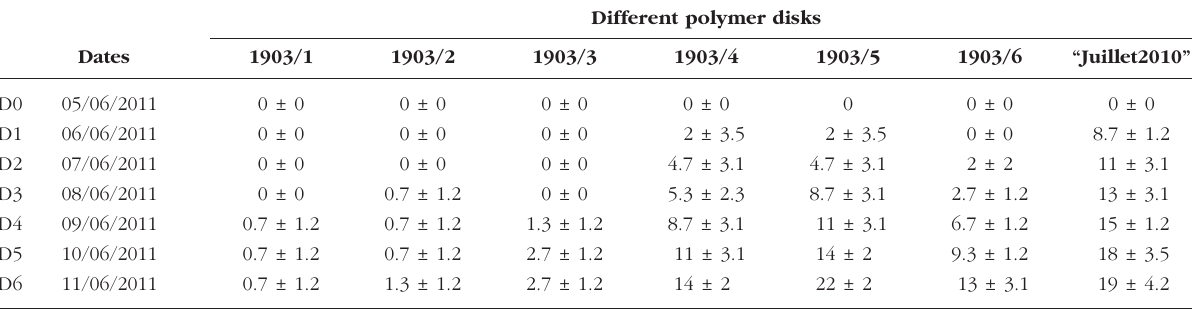
Table II ter. – Experiment A: Larval reduction rates (%) of Ae. albopictus with the same geraniol impregnated polymer disks. two months after the first